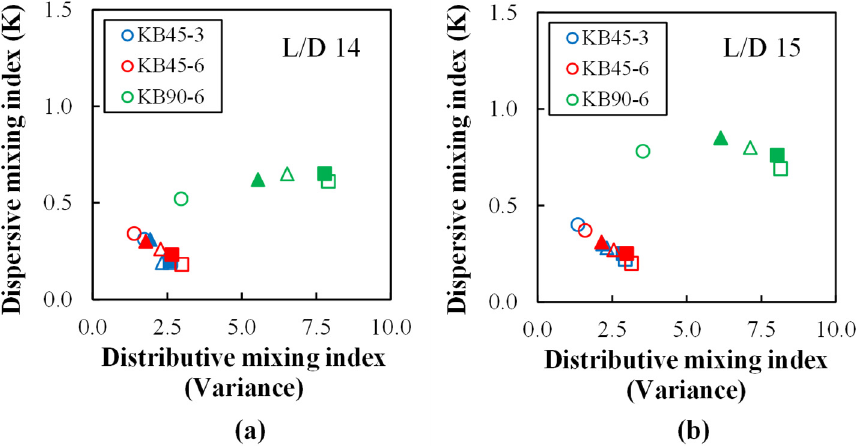
Figure 11. Mapping the mixing performance: dispersive mixing index (K) versus distributive mixing index ( σ 2 ) for different kneading blocks (KB45-3, KB45-6, and KB90-6) and screw speeds ( ○ —100 rpm, ▲ —200 rpm, ∆ —300 rpm, ■ —400 rpm, and □ —500 rpm) at ports: ( a ) L/D = 14 and ( b ) L/D = 15.